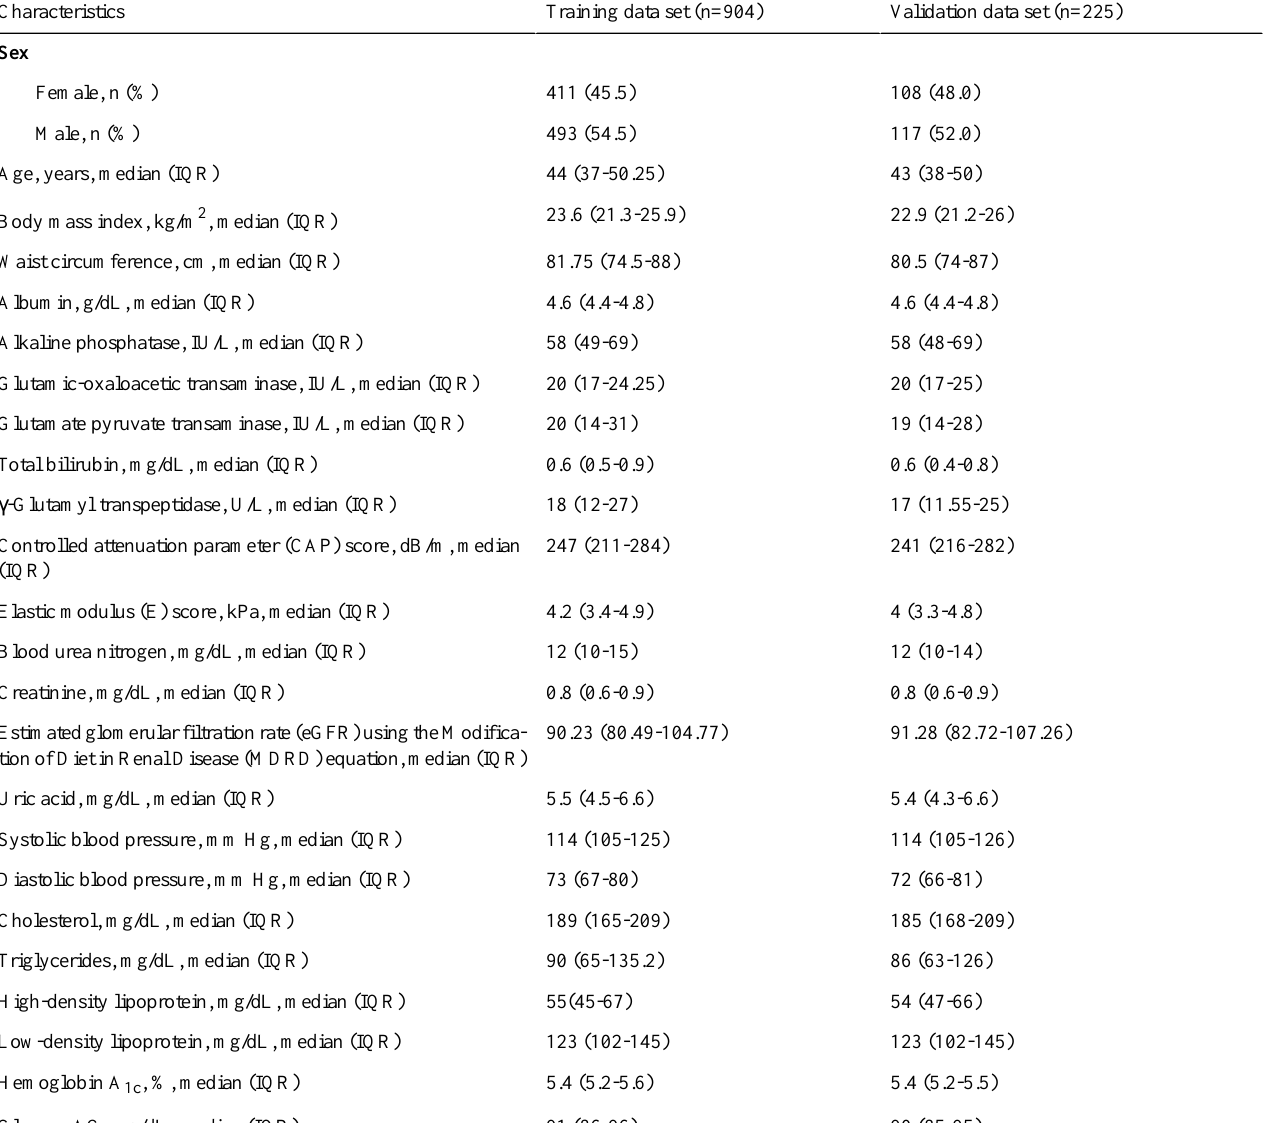
Table 2. Characteristics of participants in the training and validation data set for metabolic